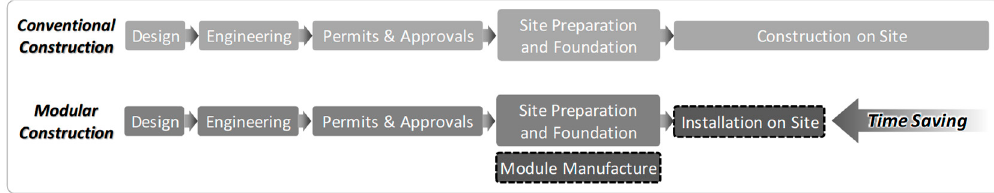
Figure 2. Comparison of modular and conventional RC construction methods [11,42] .